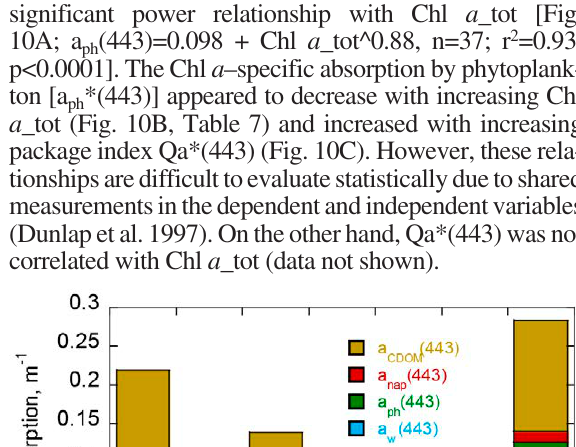
(443)]=0.39*log(Chl a _tot) –1.11, CDOM (254)]=0.14*log(Chl a _tot) –0.24, CDOM